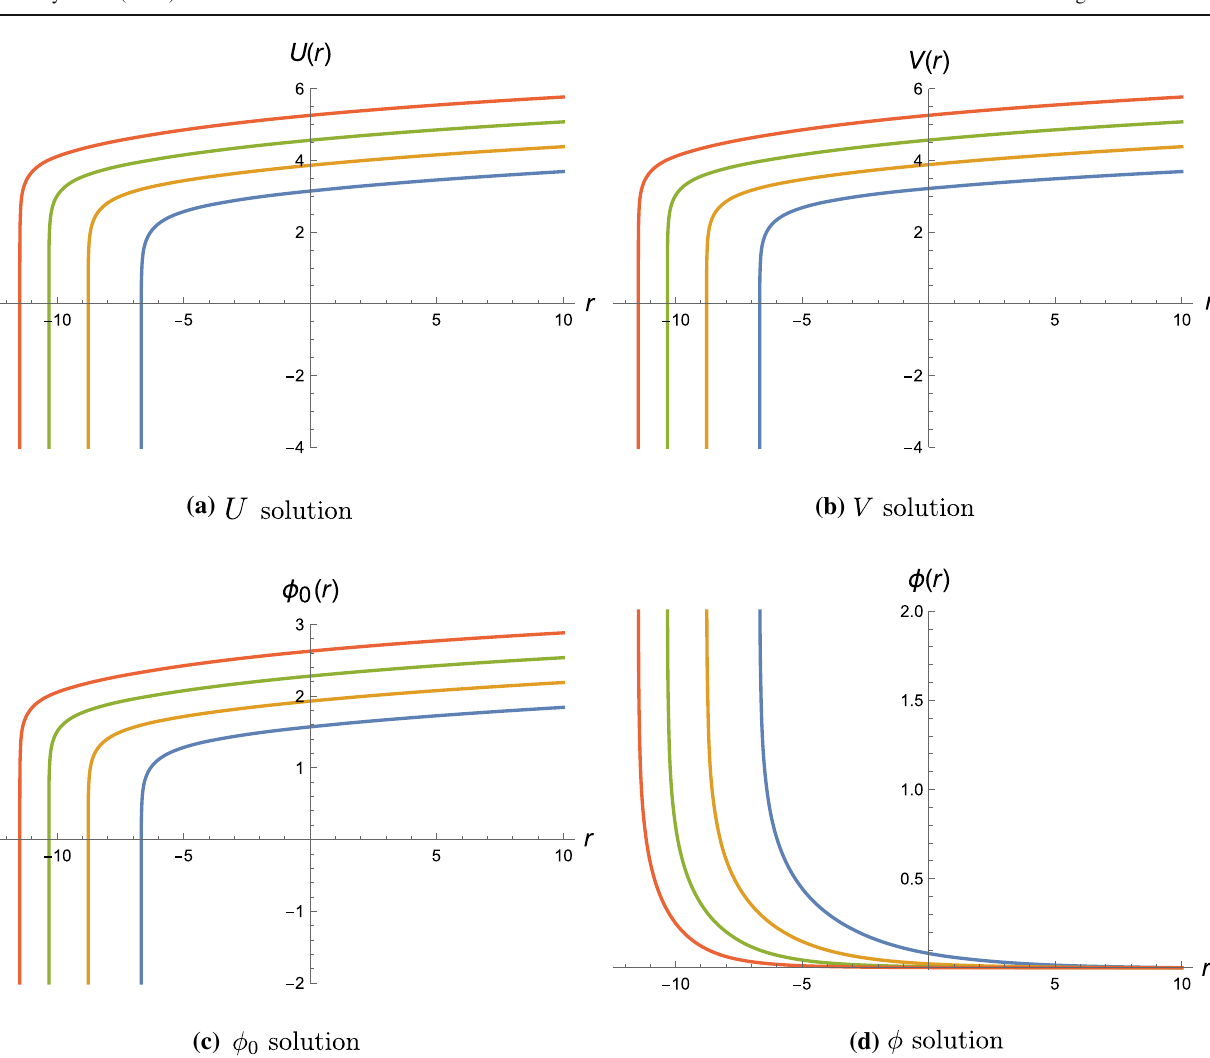
Fig. 36 Supersymmetric flows interpolating between asymptotically locally flat domain walls and Mk w 3 × H 3 -sliced curved domain walls for SO ( 3 ) twist in SO ( 4 ) gauge group. The blue, orange, green and red curves refer to g = 4 , 8 , 16 , 32, respectively